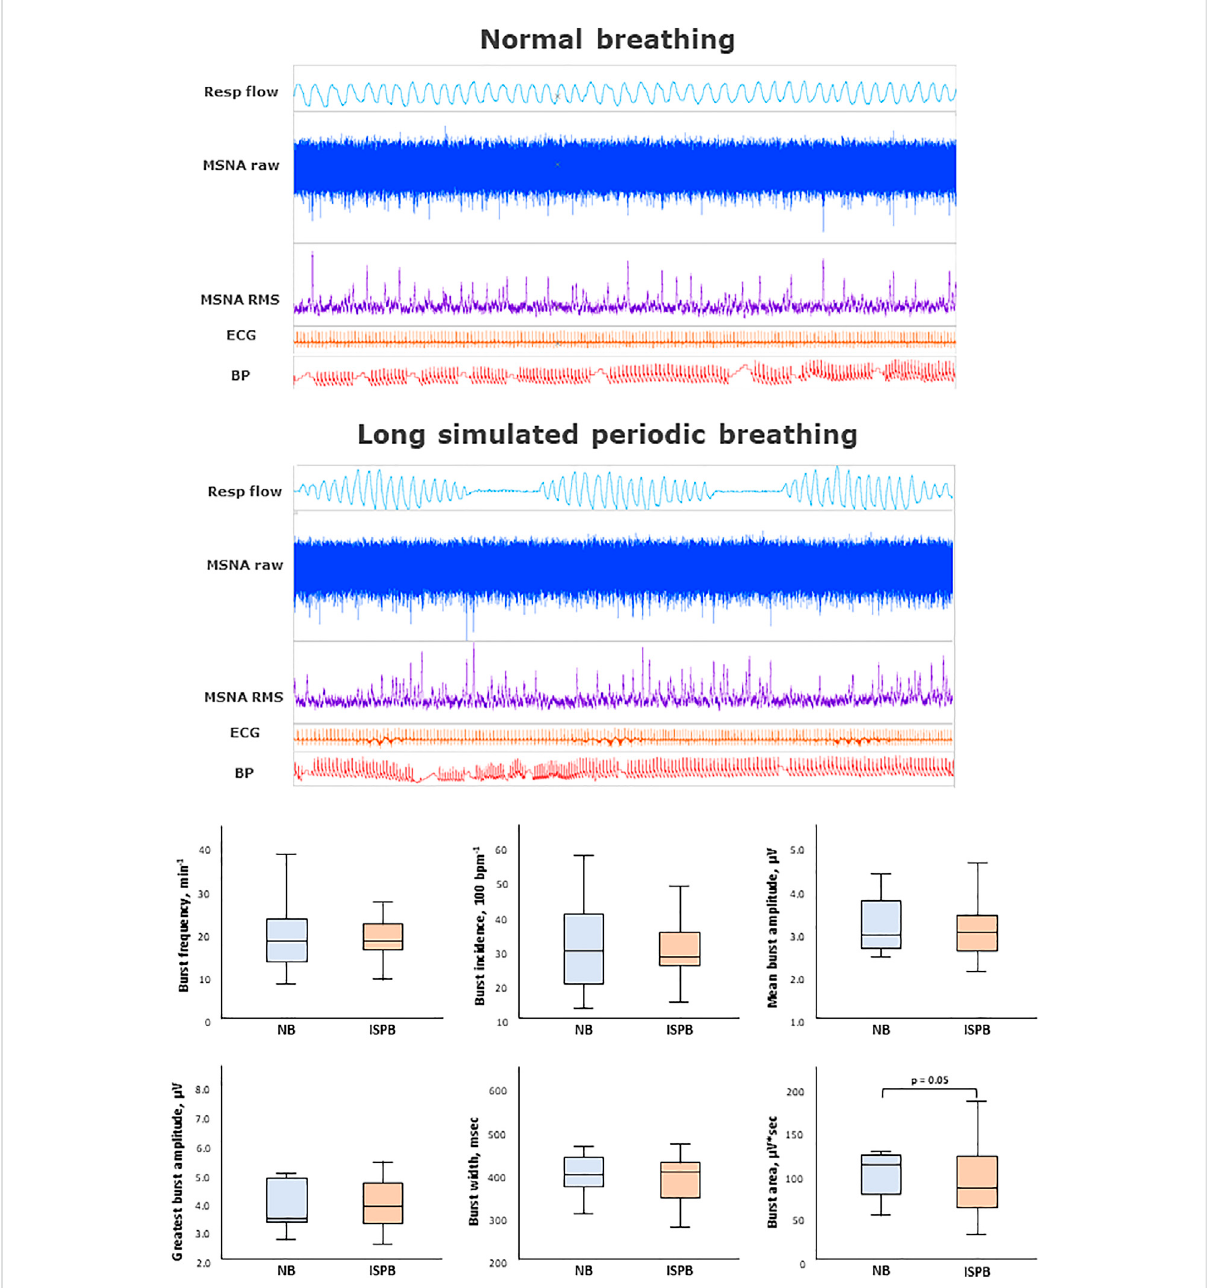
FIGURE 3 Impactoflongsimulatedperiodicbreathingonmusclesympatheticnerveactivity.Multi-unitrecordingofmuscleSNA.RMS,rootmeansquare, BP, blood pressure; Resp fl ow, respiratory fl